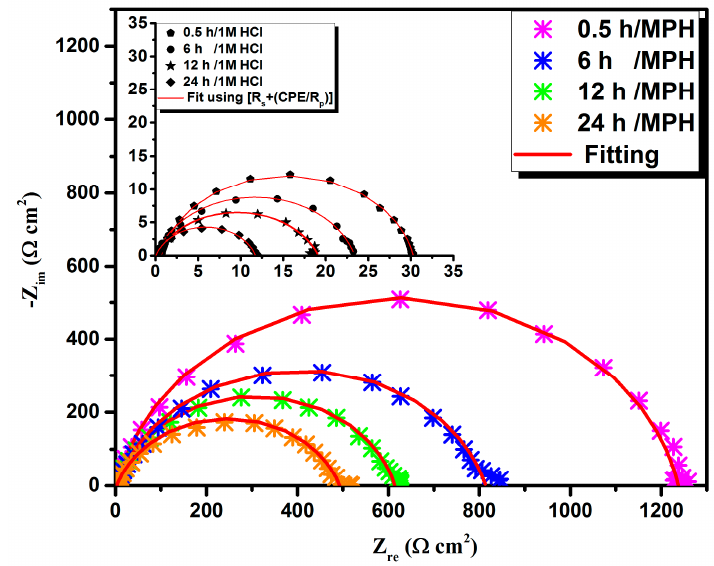
Figure 6. Electrochemical impedance spectroscopy curves of MS substrate immersed in 1.0 M HCl solution without and with 5 × 10 − 3 M of MPH at various times.